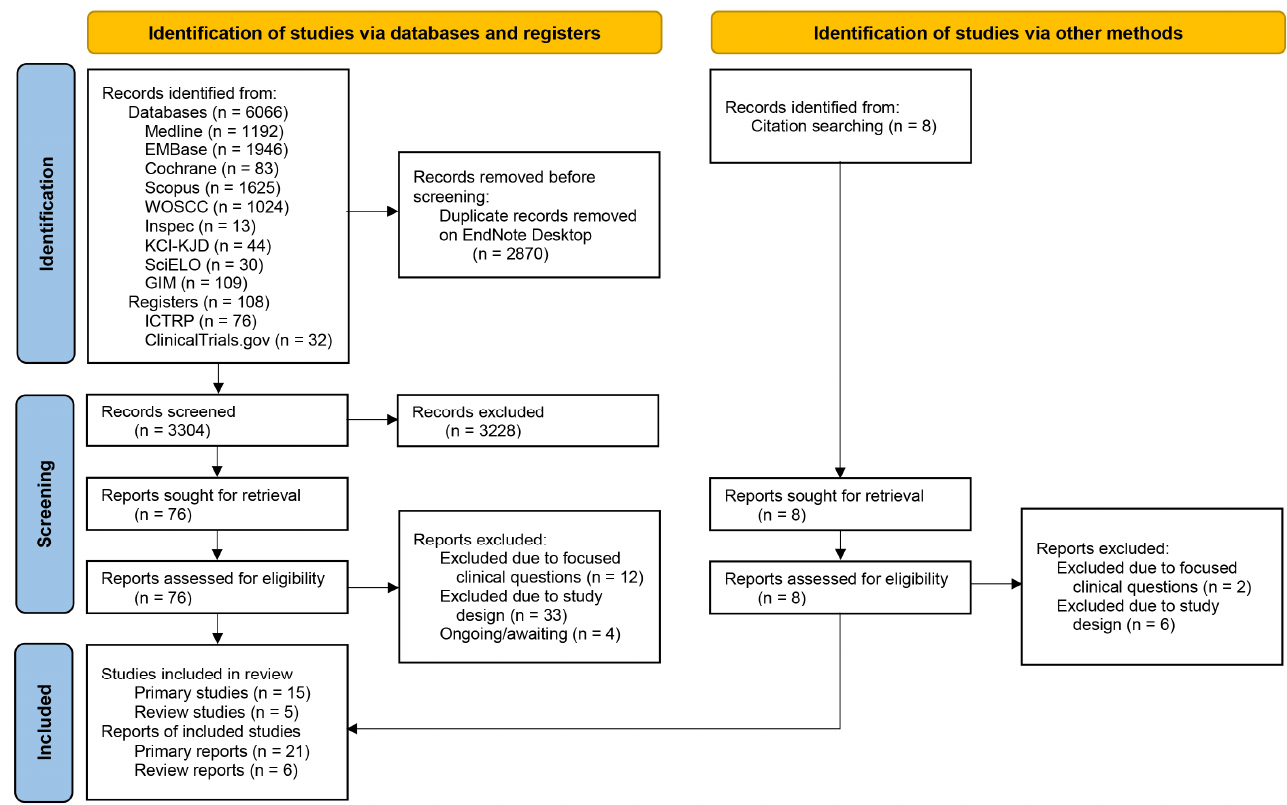
Figure 1. PRISMA 2020 flow diagram for this evidence mapping review.